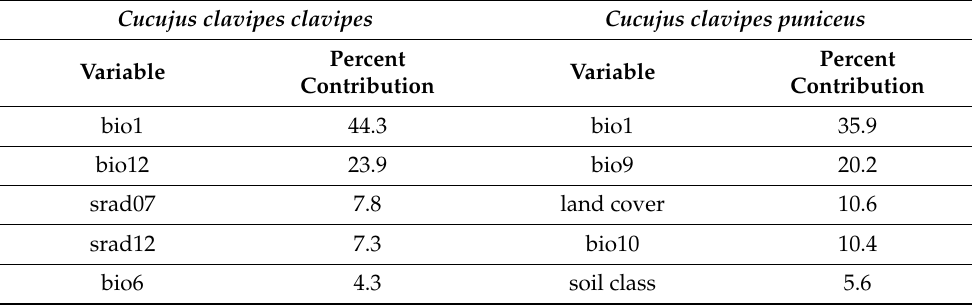
Table 2. Relative contributions of the environmental variables to the Maxent model.